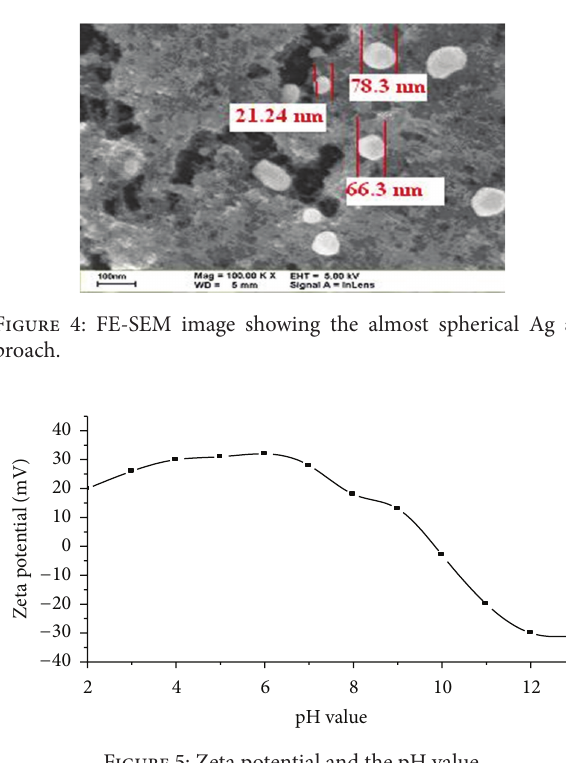
Figure 5: Zeta potential and the pH value.